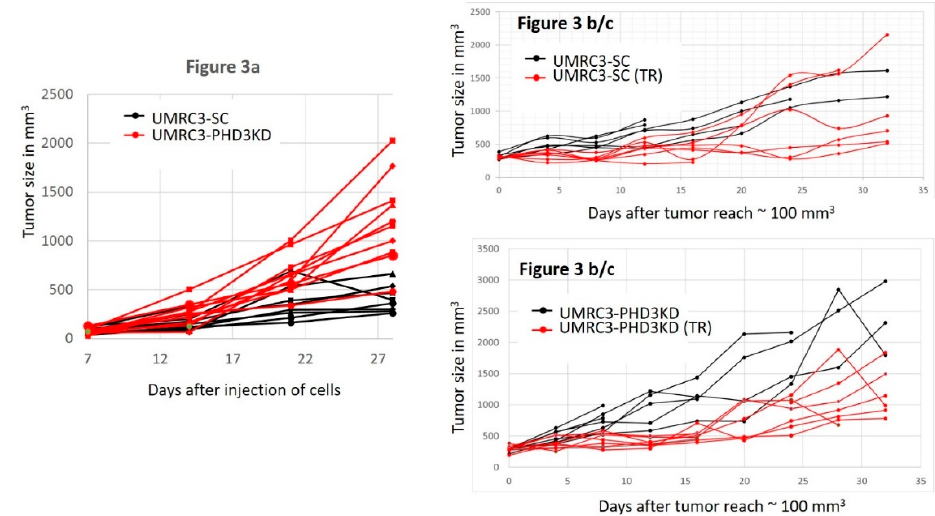
Figure A2. Individual mice from Figure 3 plotted individually. To make it easier to read, mice in Figure 3b/Figure 3c are separated in UMRC3-SC or UMRC3-PHD3KD mice.